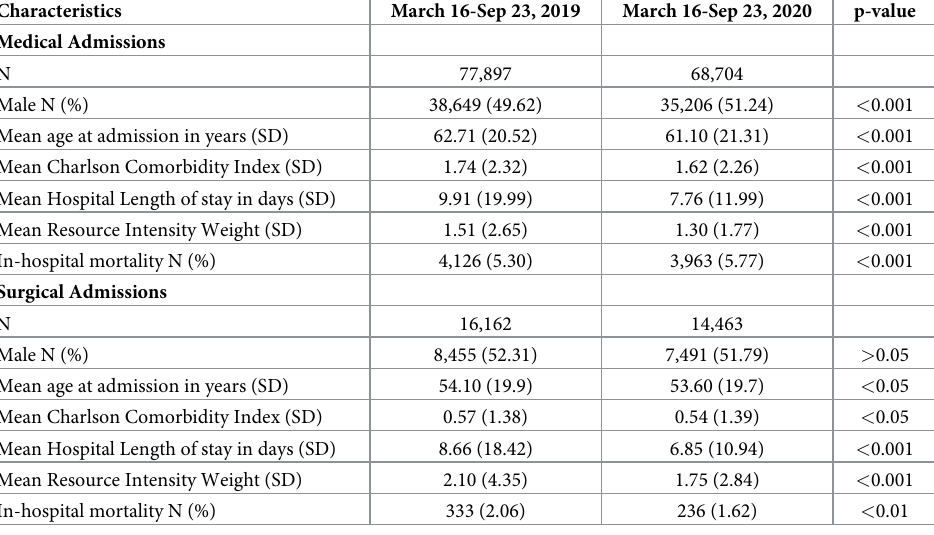
Table 1. Characteristics of patients pre COVID-19 (March 16-September 23, 2019) compared to post COVID-19 public health measures (March 16-September 23, 2020).